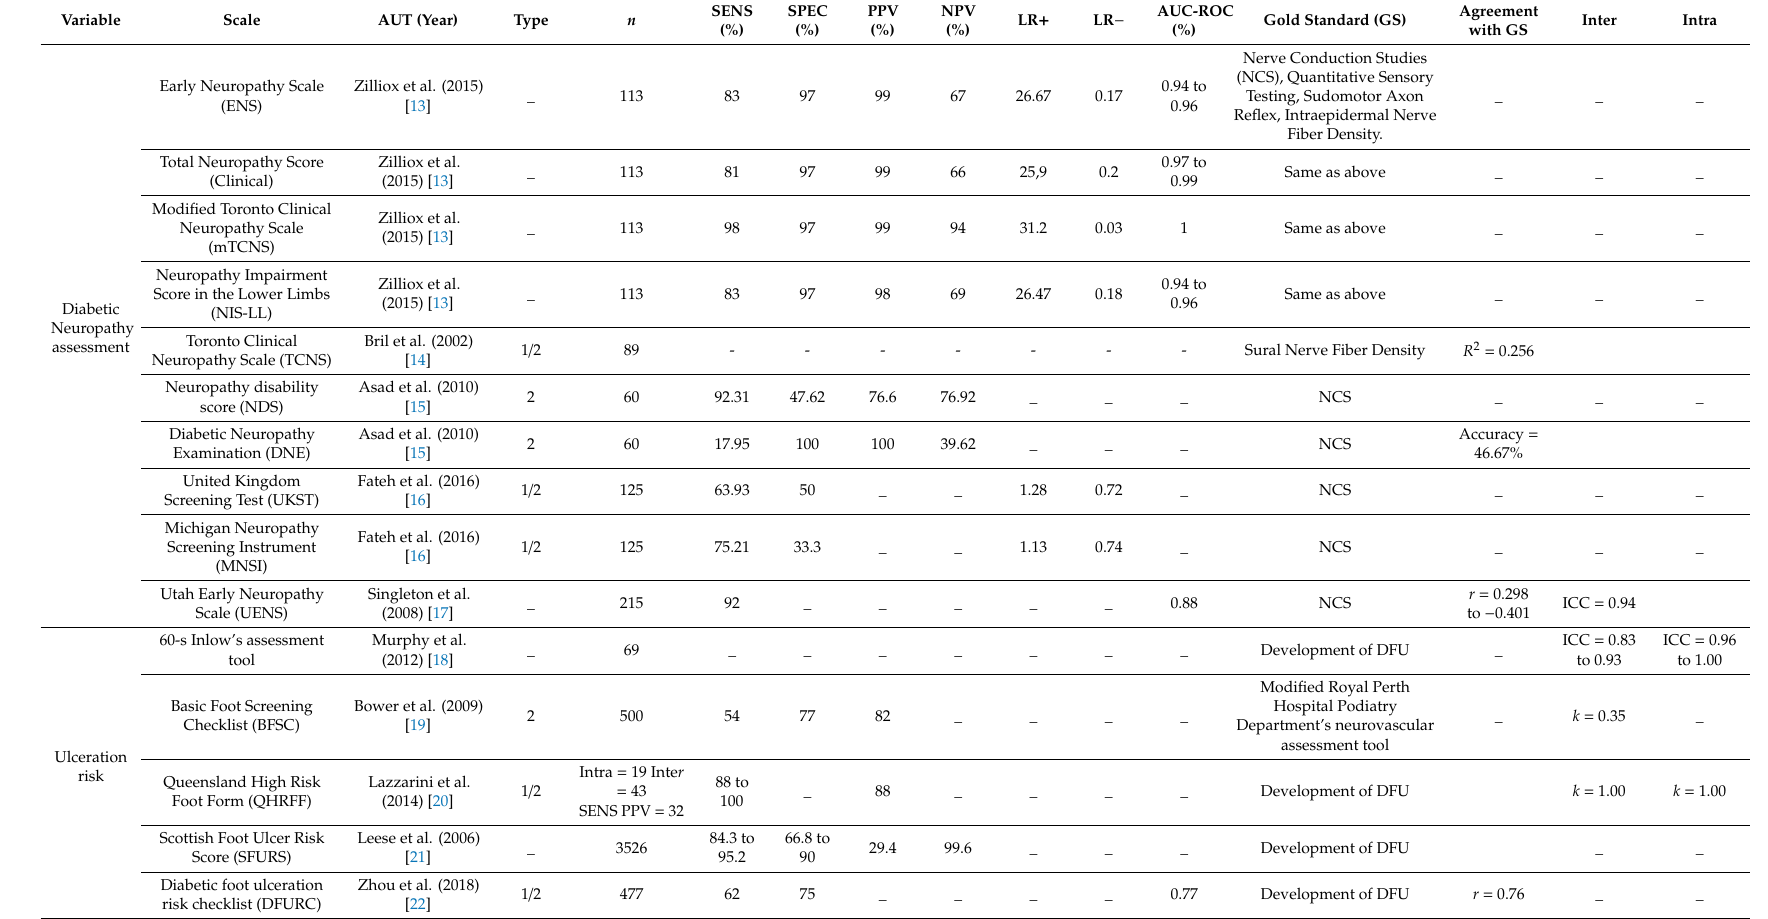
Table 1. Clinician assessment tools validated for the assessment of diabetic foot disease (DFD) related